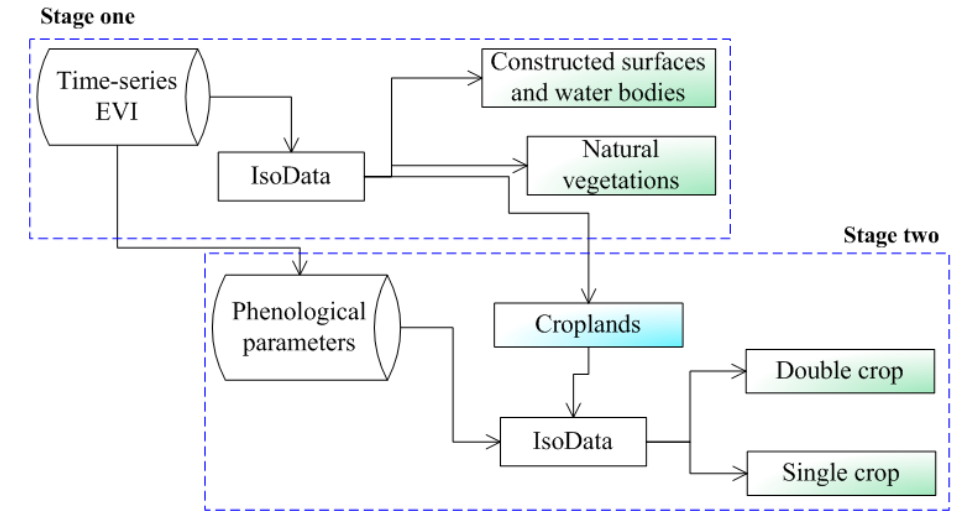
Figure 5. Flowchart of hierarchical clustering method.